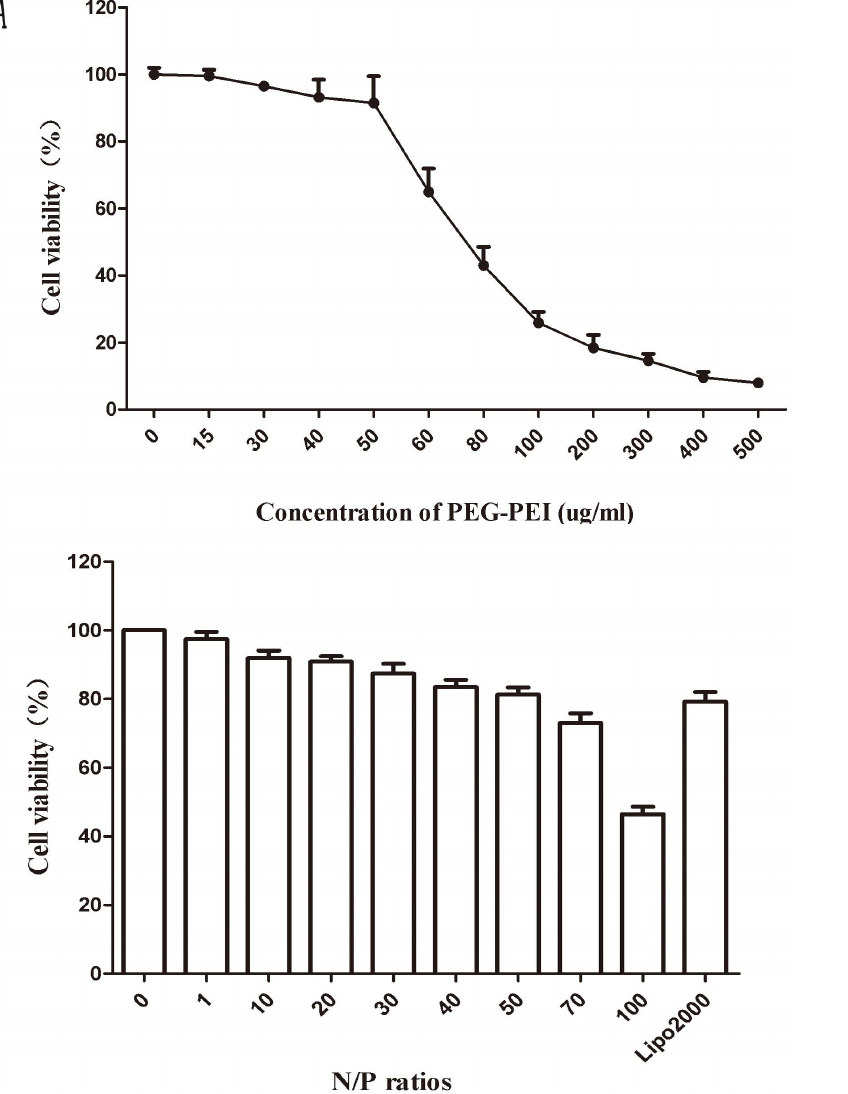
Figure 2. Invitro cytotoxicity of PEG-PEI and siROCK2 complexes toward U251 cells, as determined by an MTT assay. A In vitro cytotoxicity of PEG-PEI (at concentrations from 0 to 500 ug/ml) toward U251 cells. B In vitro cytotoxicity of siROCK2 complexes formed at different N/ P ratios toward U251 cells. The concentration of siROCK2 was 1.33 ug/mL (100 nM) in each well and the incubation time was 24 h. The data are shown as the means 6 SD;